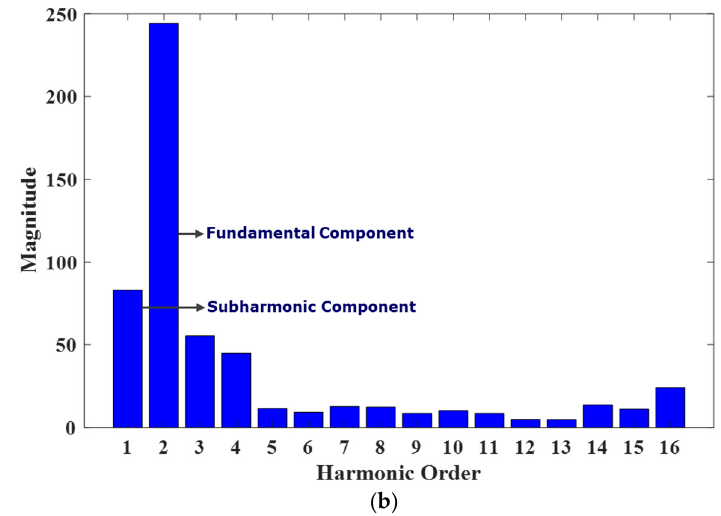
Figure 3. For reference machine: ( a ) MMF Plot and ( b ) harmonic distribution.